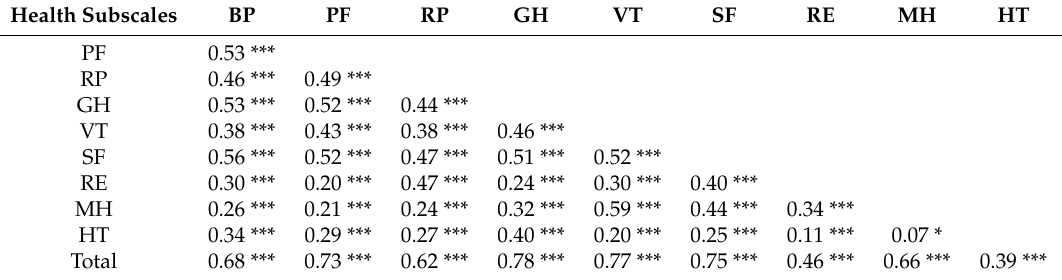
Table 4. Correlation coe ffi cients between subscales and between subscales and total